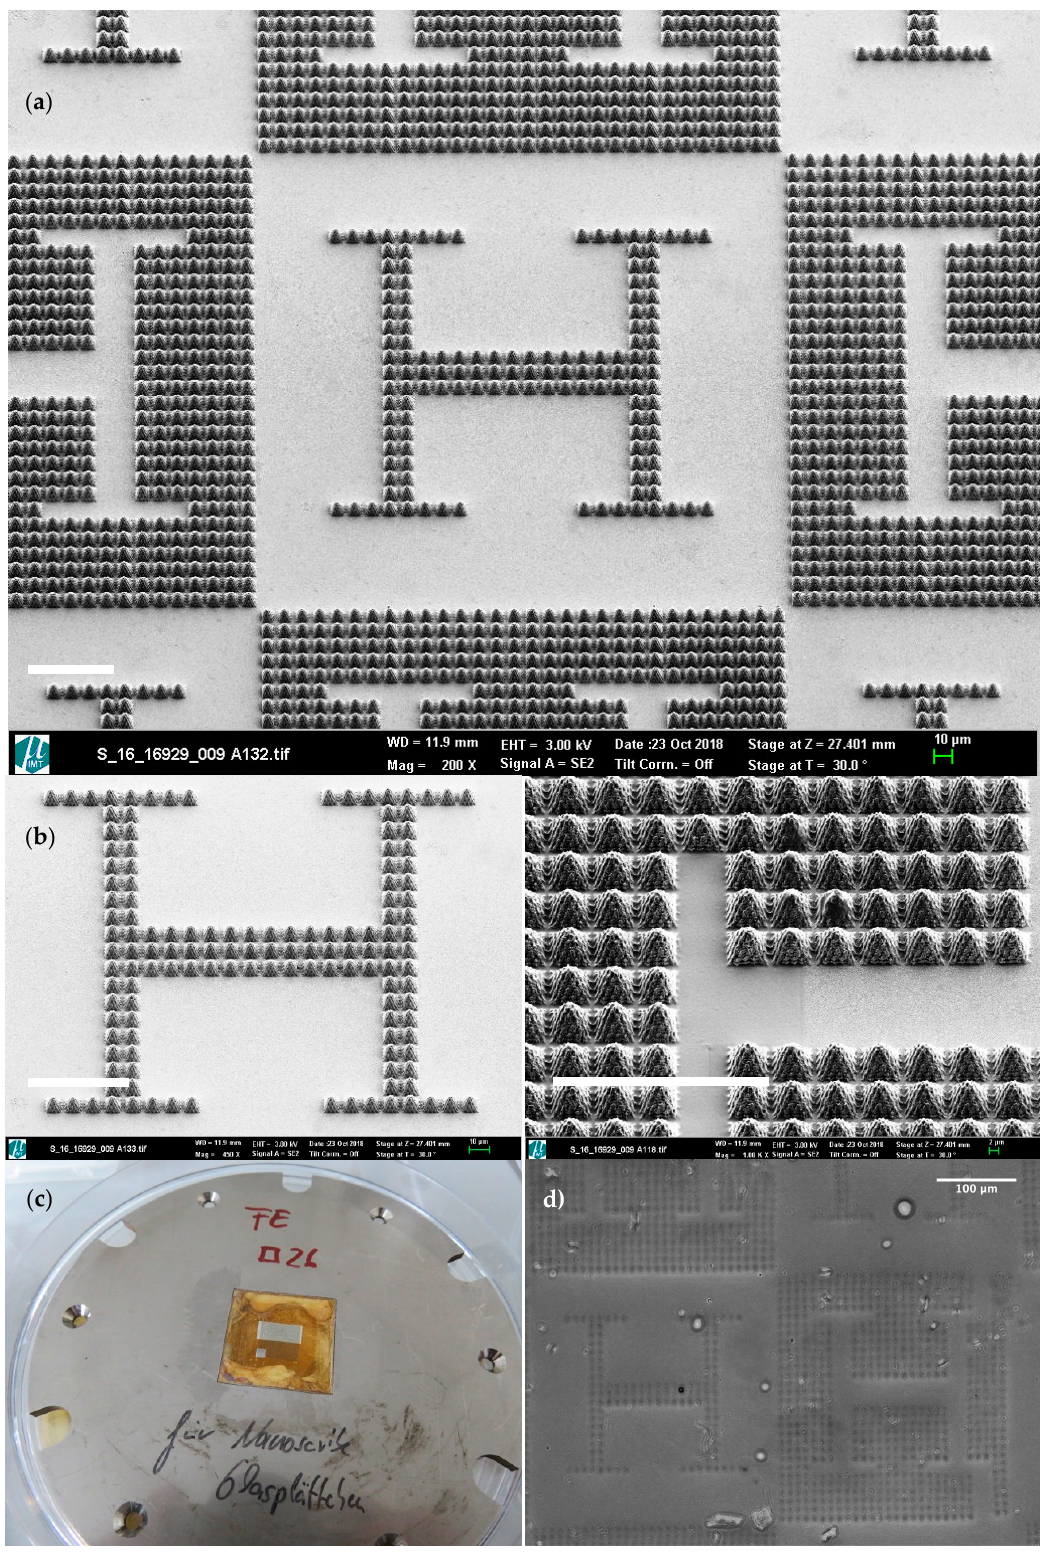
Figure 2. ( a ) Direct laser written microstructures as master models (SEM). ( b ) Detailed views of vascular-like microstructures with different magnification (SEM). ( c ) Mold insert obtained after electroplating and mounted in the hot-embossing tool (digital camera). ( d ) Pattern transferred to the polyacrylamide gel (stereoscopic microscope). White scale bars in a and b = 100 µm.